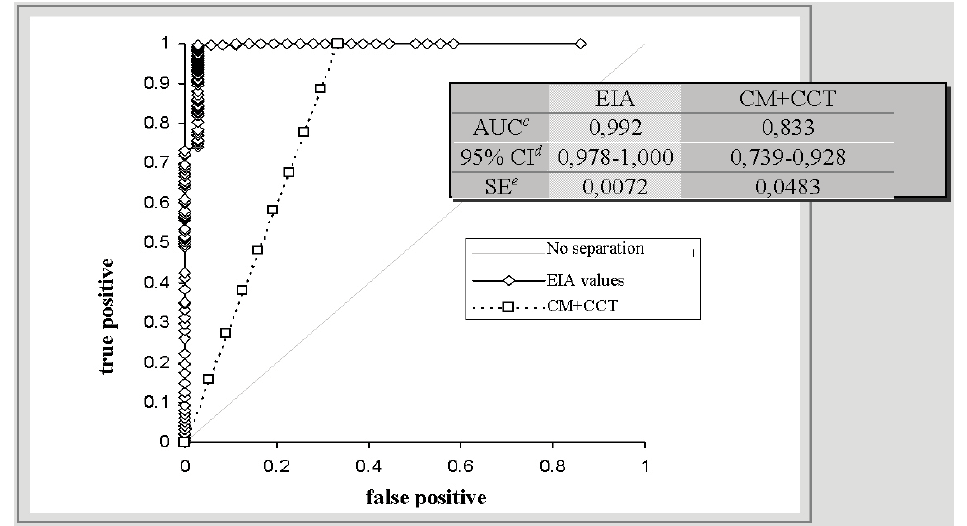
a EIA, immunoenzyme method; b N, total number of examinees; c AUC, surface below the ROC curve/line; d 95% CI confidence interval; e SE, standard